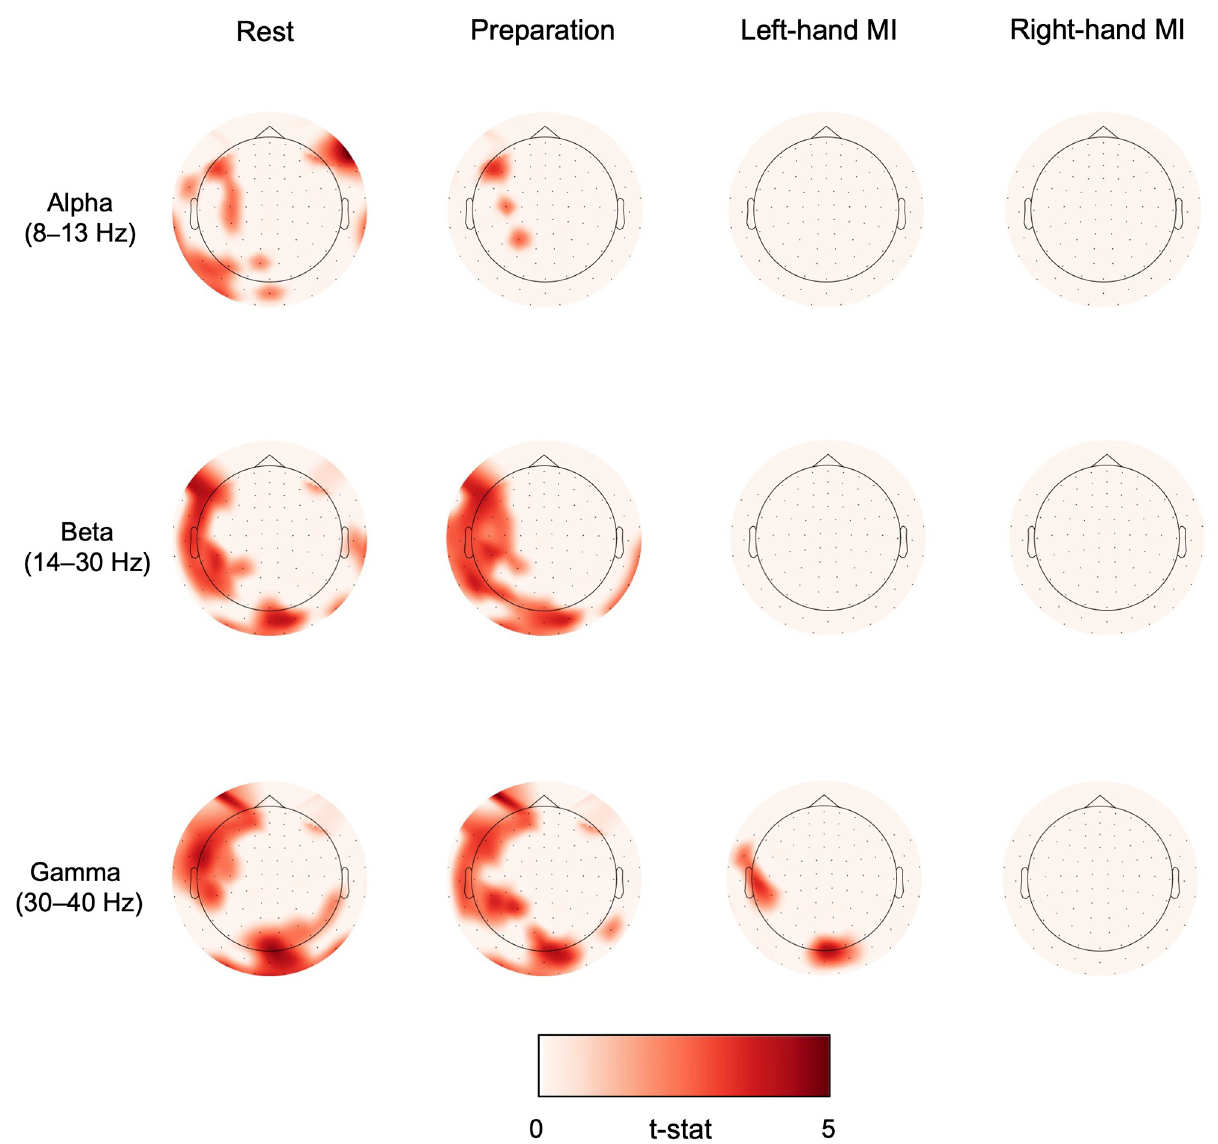
Fig 6. Channel-specific power increase in Data 1. MEG gradiometers in which a linear power increase over trials was statistically significant ( t -statistic shown for channels in which p < 0.05) for alpha-, beta- and gamma-band oscillations when delivering visual feedback (Data 1).